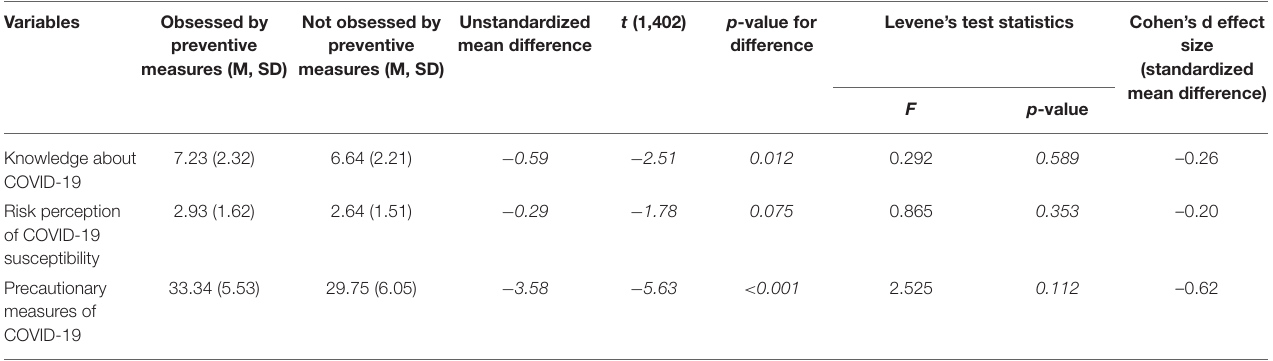
TABLE 4 | The self-reported obsession by preventive measures of COVID-19 and the COVID-19 knowledge, risk perception, and precautionary measures among medical students.